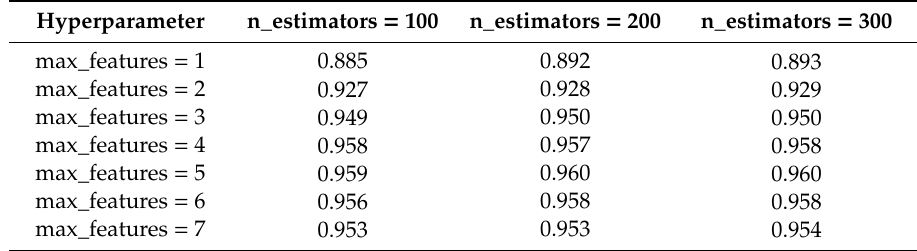
Table 10. Accuracy by Random Forest Hyperparameter.